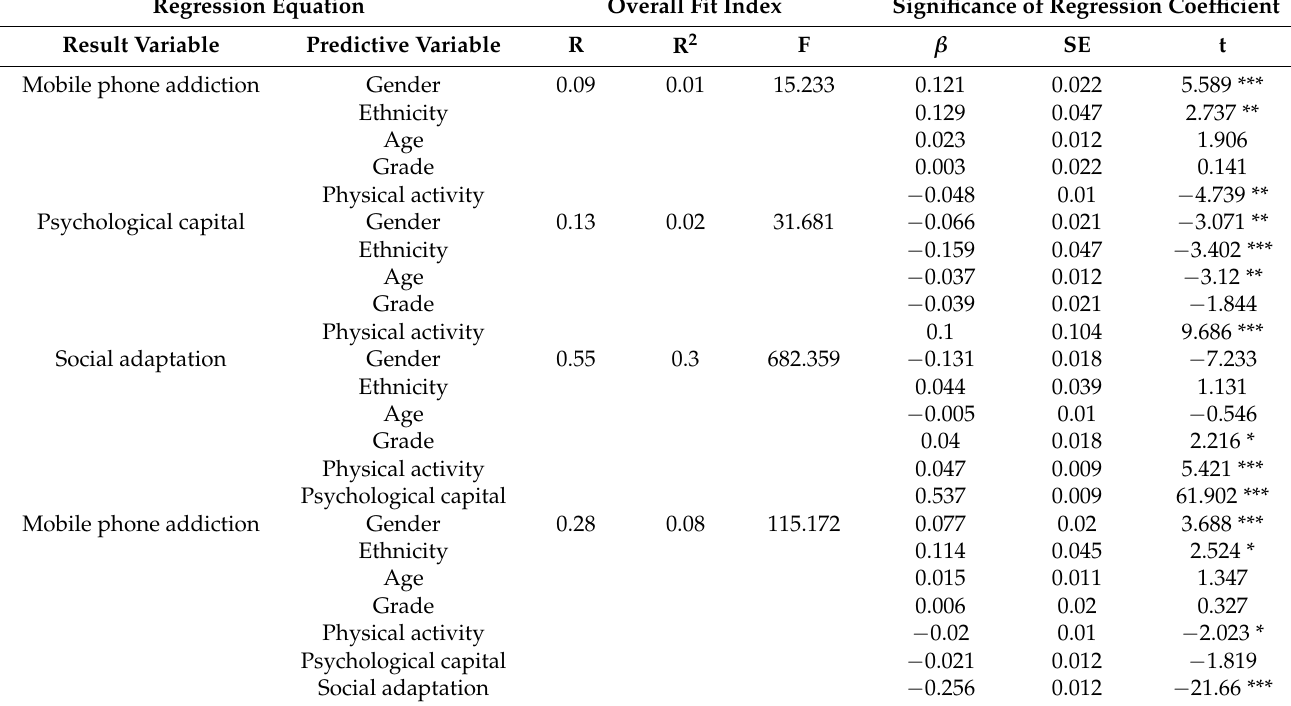
Table 3. Regression analysis of variable relationships in the model.